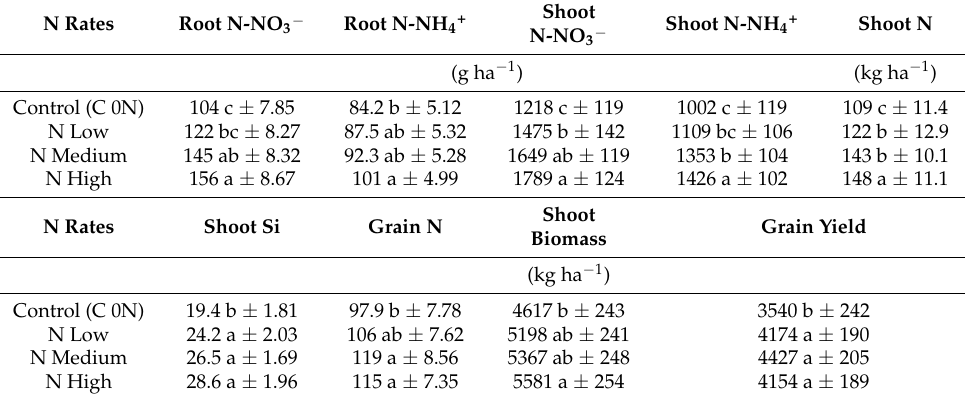
Table 5. Wheat root nitrate (N-NO 3 − ); root ammonium (N-NH 4+ ) accumulation; shoot N-NO 3 − ; shoot N-NH 4 + ; shoot N; shoot Si accumulation; grain N accumulation; shoot biomass and grain yield as a function of N levels.